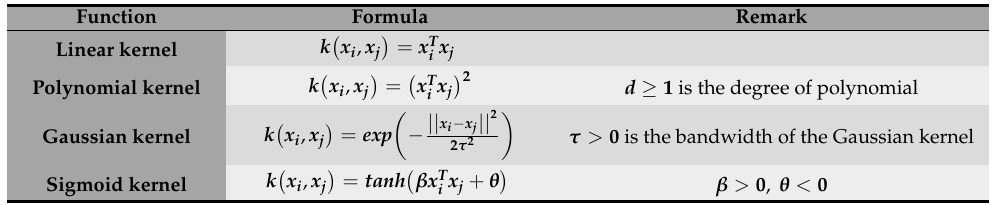
Table 4. Kernel functions commonly used in regression